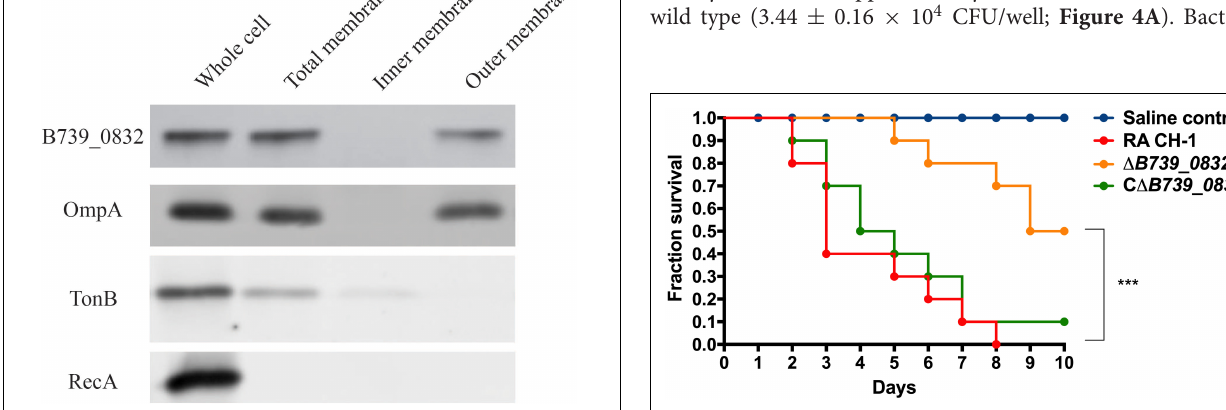
FIGURE 2 | Membrane localization of R . anatipestifer CH-1 B739_0832 protein. Isolated subcellular fractions of R. anatipestifer cells were prepared as described in “Materials and Methods” and analyzed using Western blot. Results indicate that B739_0832 protein localizes in the outer membrane. OmpA is a confirmed outer membrane protein in R. anatipestifer , RecA is a known cytoplasmic protein and TonB is a known inner membrane protein. See Supplementary Figure 3 in the Supplementary Material for more information.